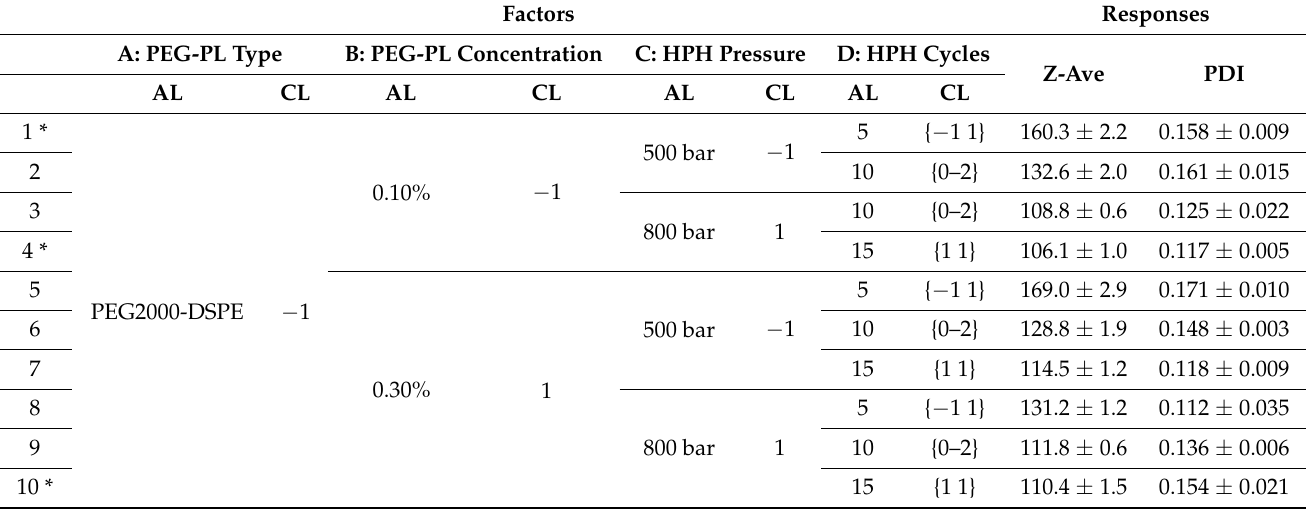
Table 1. D-optimal experimental design matrix and the measured values for the responses. Factors